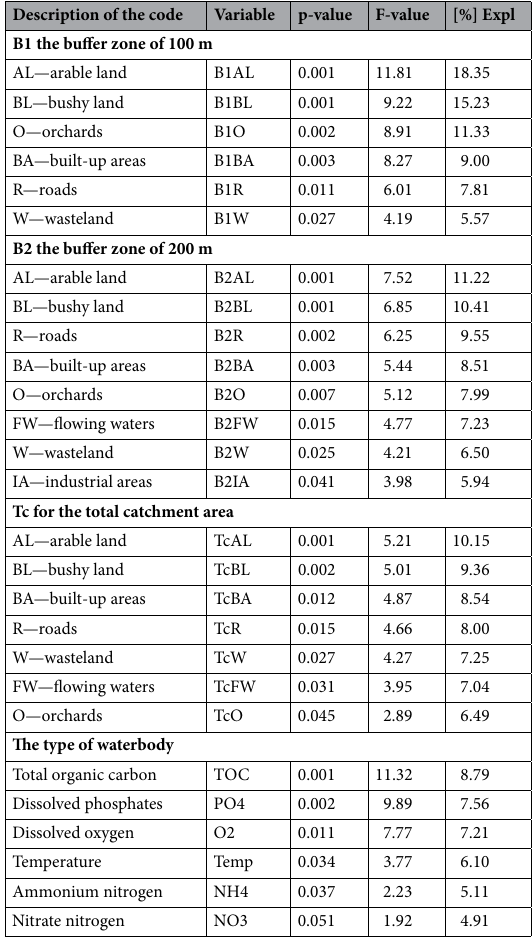
Table 3. Correction coefficients for CCA model for the buffer zone of 100 m, 200 m, total catchment and type.